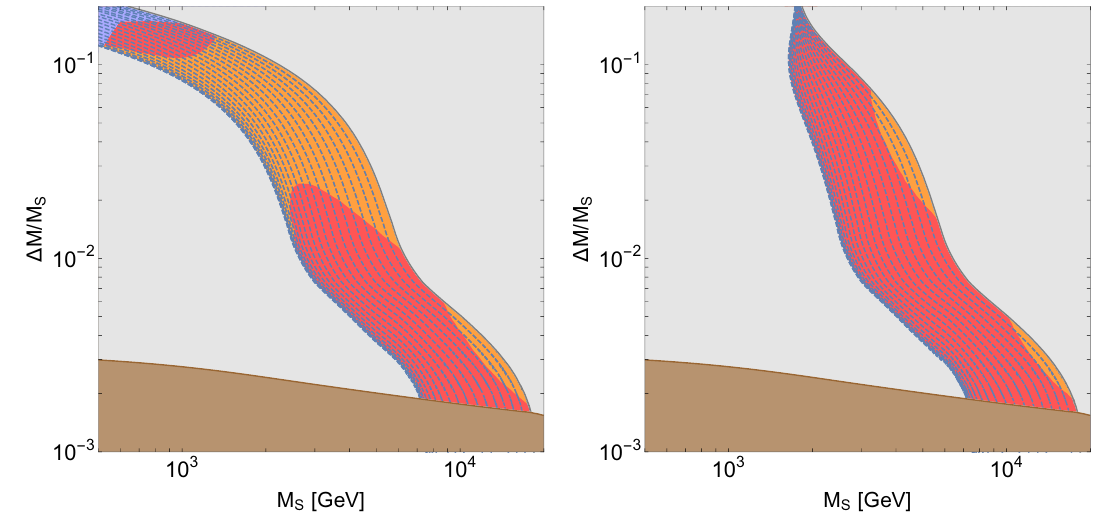
Figure 8 . Experimental limits on thermally produced real scalar DM coupling via a coloured mediator to u -quarks. The left and right panel show the case of the Higgs portal coupling (cid:21) 3 = 0 : 0 and (cid:21) 3 = 1 : 5, respectively. The null-results of XENON1T exclude the red part of the parameter space. The orange region indicates the reach of a future Darwin-like direct detection experiment. The upper gray area requires y (cid:21) 2 in order to reproduce the correct relic abundance. In the lower grey region the observed relic abundance cannot be achieved via freeze-out since the thermal abundance is set by the gauge interactions of the mediator. In the brown region the mass splitting is so small that the bound states is lighter than twice M S . We indicate contours of constant y in the range f 0 : 1 ; 2 g by the dashed